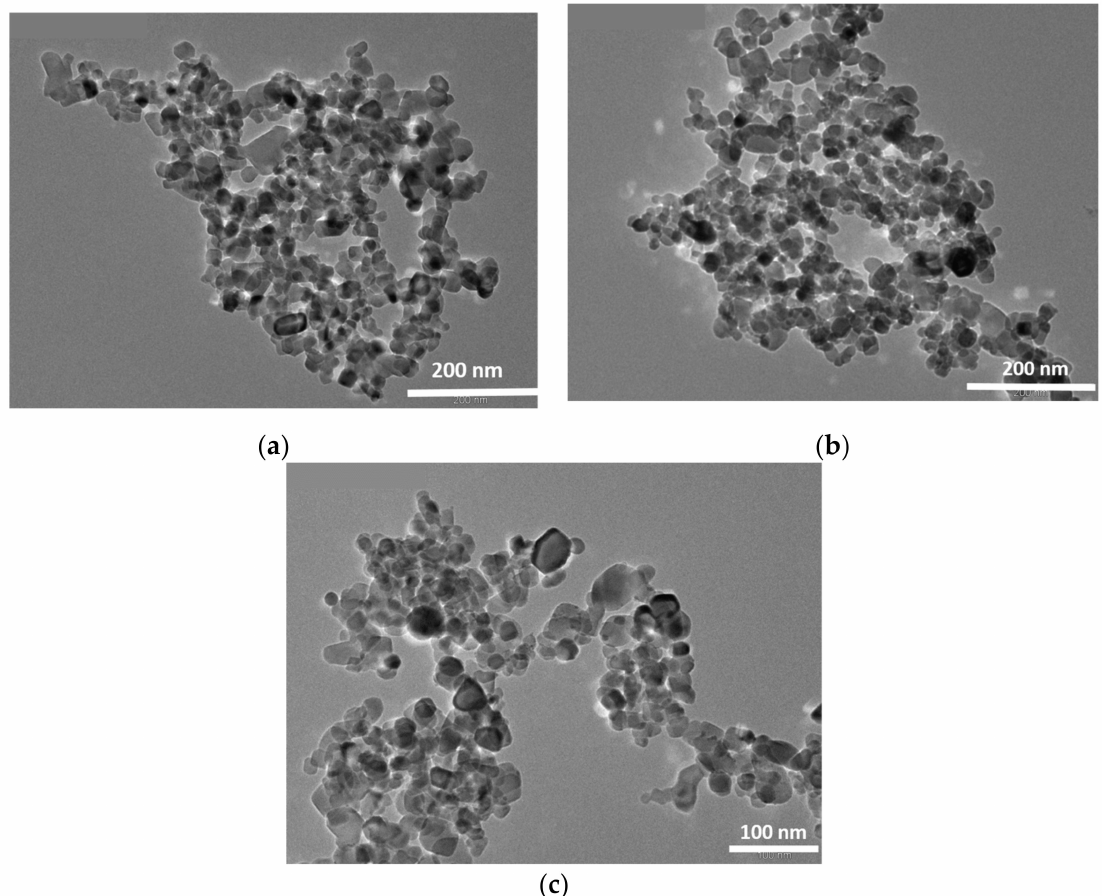
Figure 2. The TEM images of ( a ) TiO 2 , ( b ) Pd/TiO 2 , ( c ) Cu/TiO 2